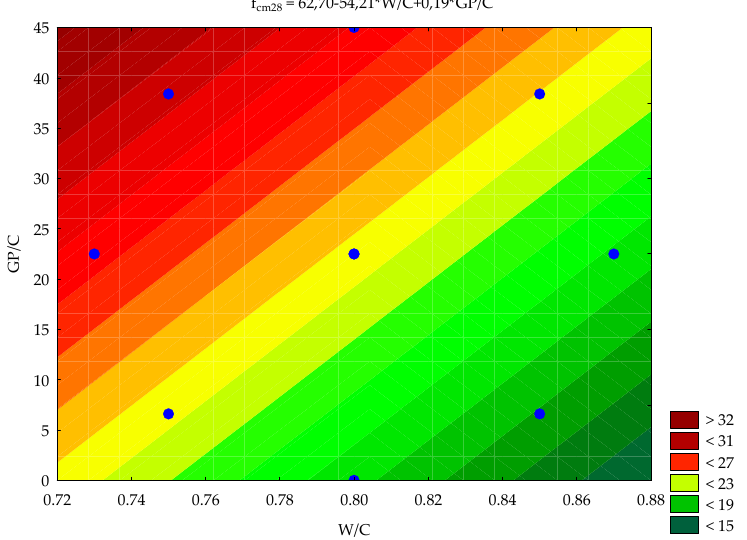
Figure 9. Contour diagram of the relationship between compressive strength and the amount of glass powder and water–cement